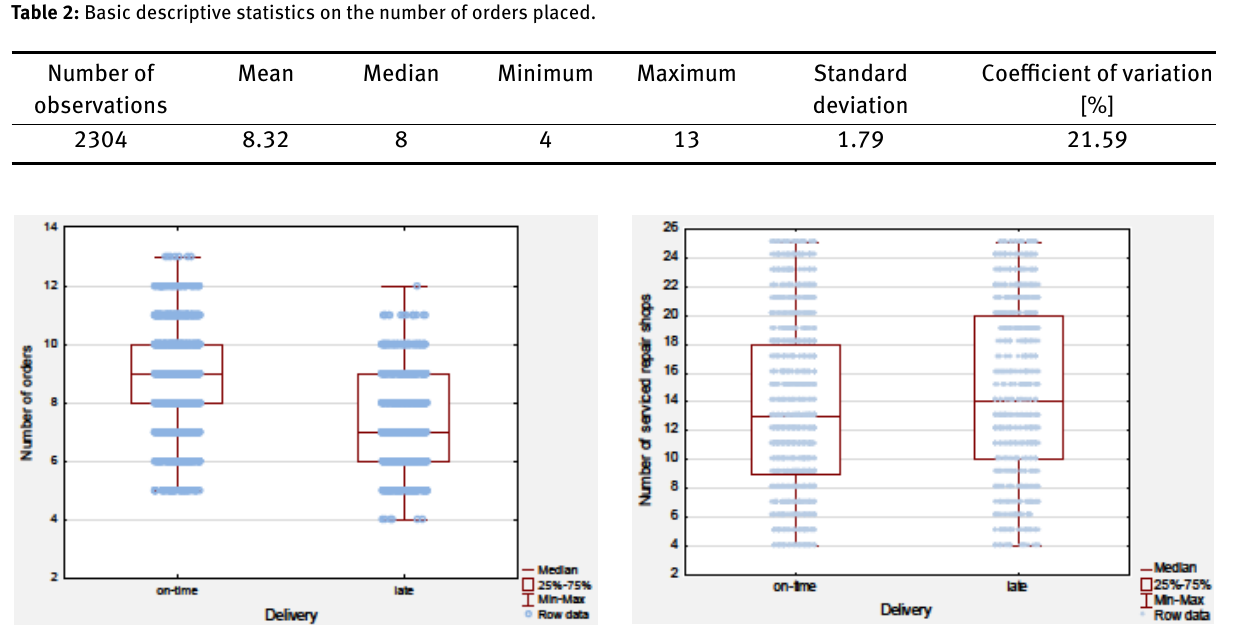
Table 2: Basic descriptive statistics on the number of orders placed.